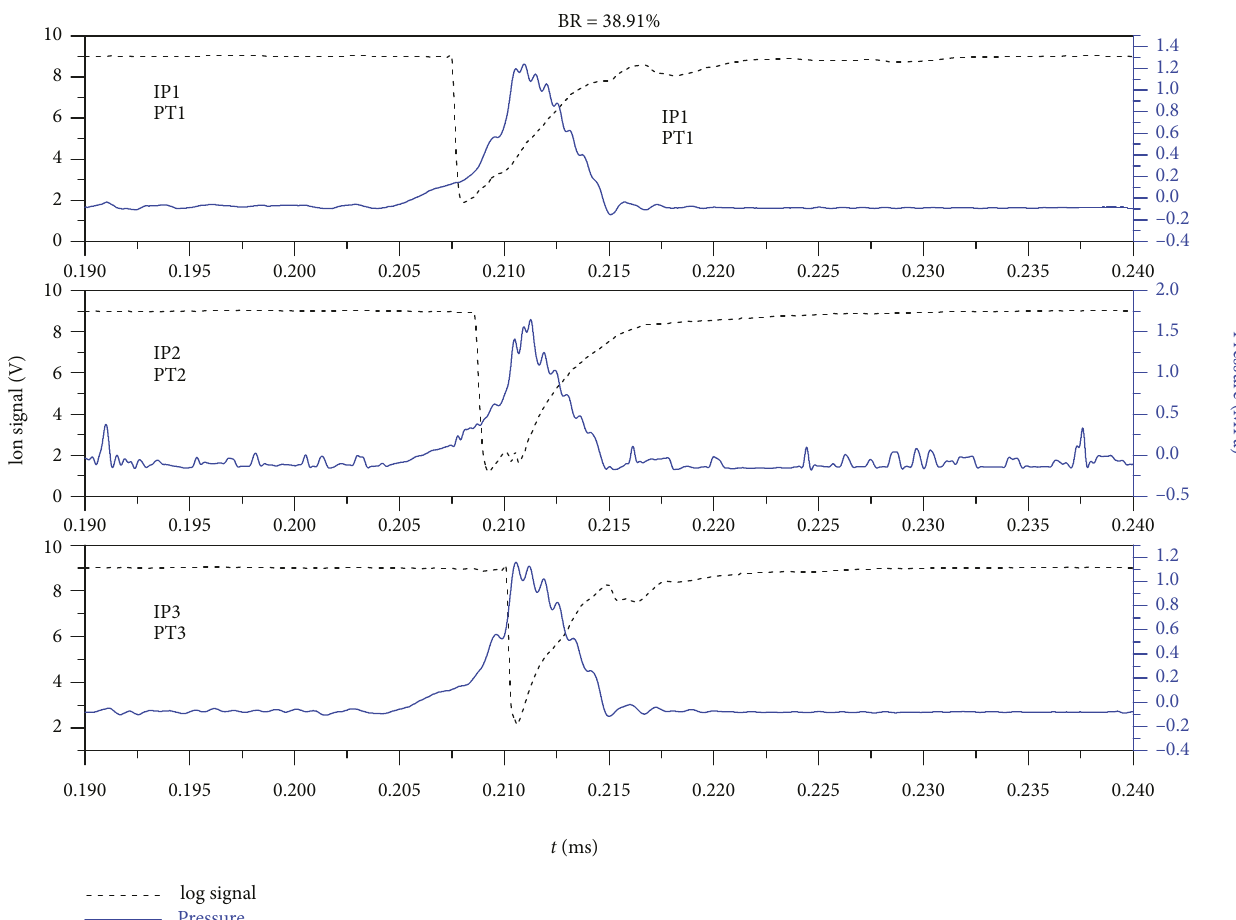
Figure 9: The ion and pressure signals of a single cycle operation.